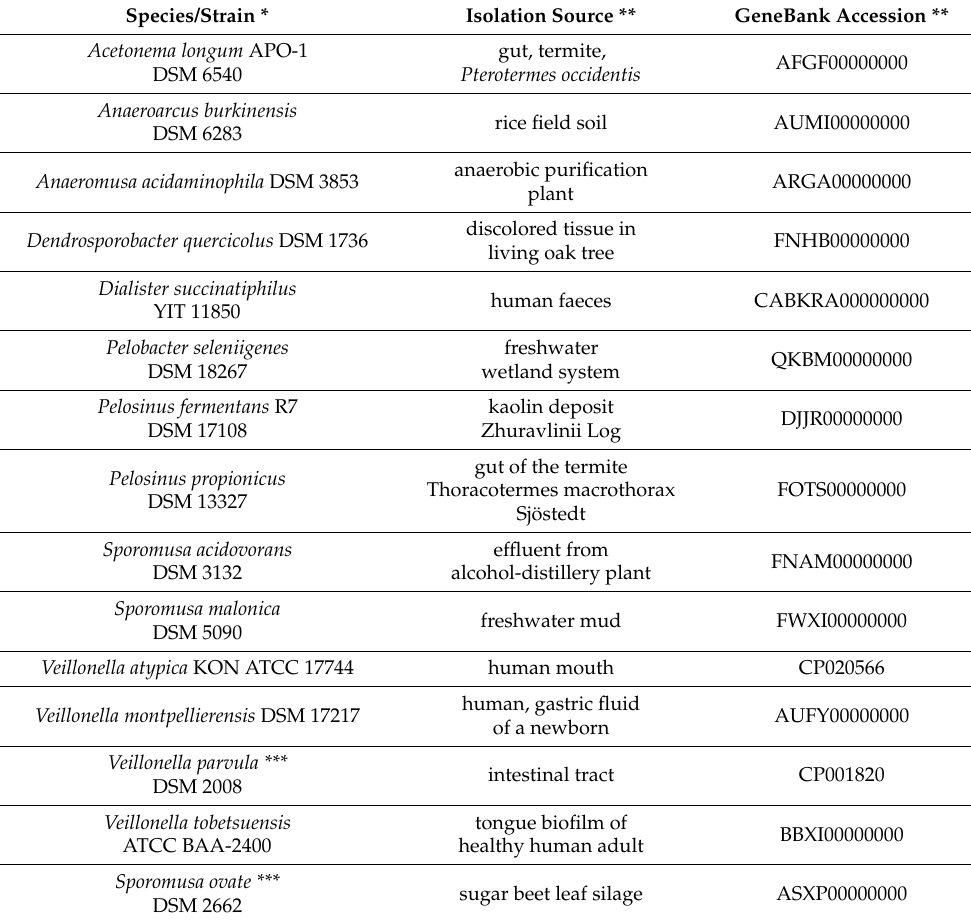
Table 1. Microbial genomes containing cobU/T orthologues with predicted ArsAB function for phenolyl Cba